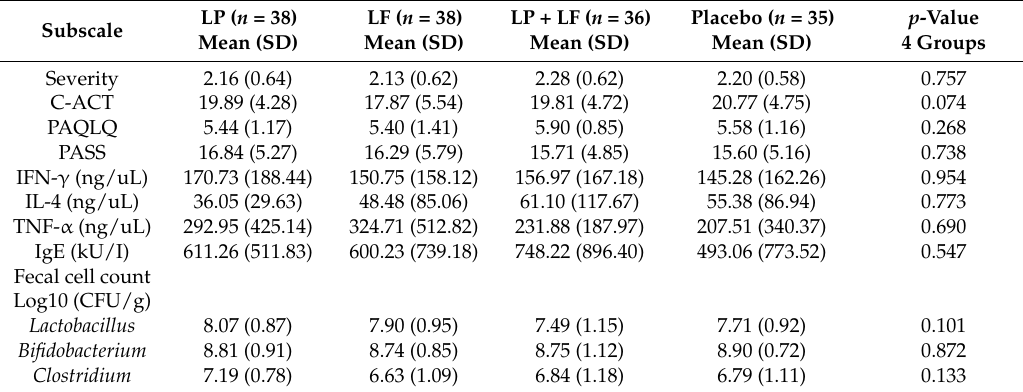
Table 2. Subscale measures at baseline ( N = 147).